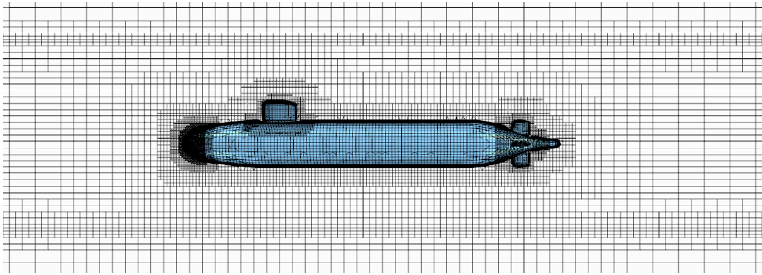
Figure 7. Computational domain meshing.